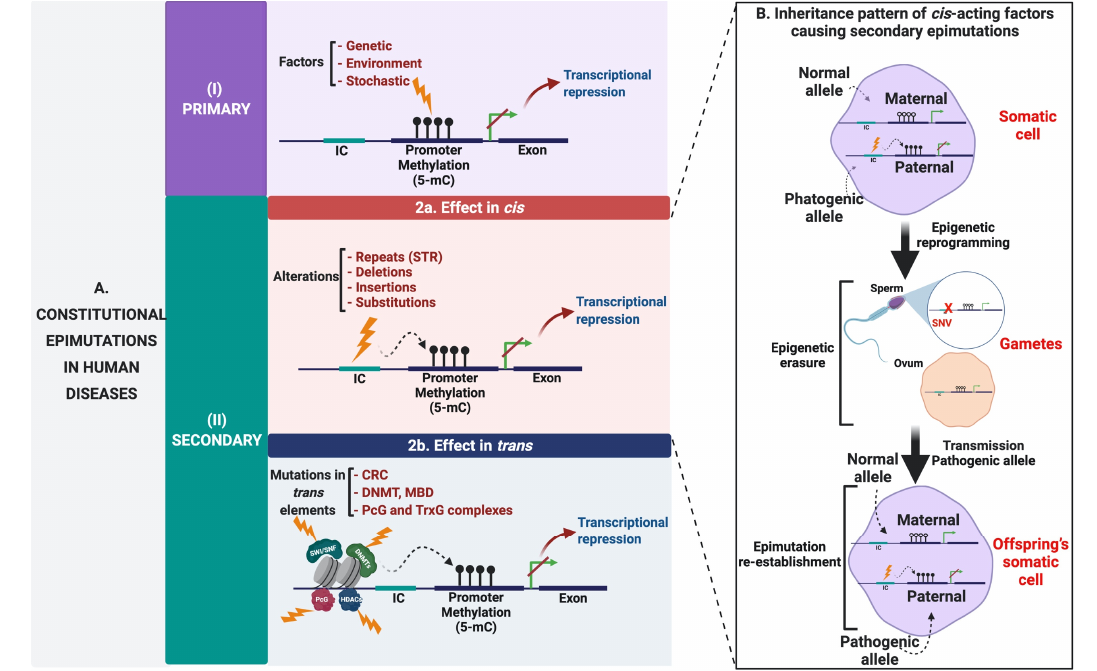
Figure 4. Constitutional epimutations in human diseases. ( A ) Constitutional epimutations that cause disease in humans include mechanisms that can occur without altering the DNA sequence (primary epimutations) or as a consequence of a DNA mutation in a cis- or trans-acting factor (secondary epimutations). ( I ) Primary epimutations result as a consequence of the action of different factors that directly modify the methylation pattern in the promoter region of a tumor suppressor gene. ( II ) Secondary epimutations that act in cis ( 2a ) may be a consequence of alterations that affect the conserved parental region IC and generate hypermethylation of the promoter region. ( 2b ) Secondary trans-acting factor epimutations occur as a result of mutations in trans elements such as CRC, DNMT’s, MBD, and PcG/TrxG complexes, which indirectly lead to an aberrant methylation state in the promoter region of the gene. In all cases, this leads to transcriptional repression of the tumor suppressor gene. ( B ) The transmission of the pathogenic allele occurs dominantly (in this example the paternal allele) starting from an alteration in cis (secondary epimutation in cis ) in somatic cells. However, there is an erasure of the epimutation (epigenetic erasure) in the gametes, but the alteration in cis is held (in this example an SNV), which can be transmitted to the offspring while the epimutation is restored in somatic cells, being able to generate epigenetic mosaicism.